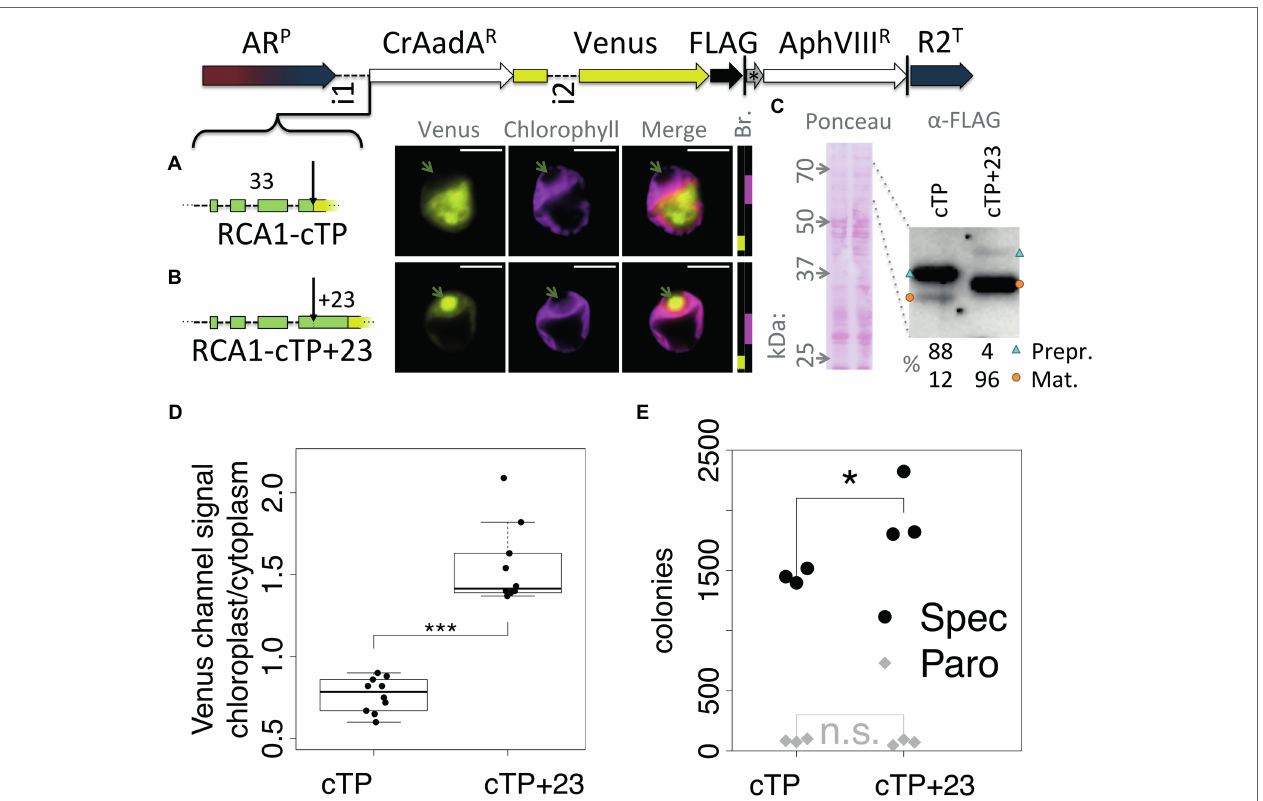
FIGURE 2 | An alternative cargo confirms the requirement for extending RCA1-cTP past the cleavage site. (A–C) The spectinomyin resistance gene AadA, codon optimized for Chlamydomonas (CrAadA R ) and equipped with a short linker sequence at the C-terminus, was inserted between RCA1-cTP ± 23 and Venus, and transformants analyzed using fluorescence microscopy and immunoblotting. Green arrows highlight the pyrenoid in (A,B) ; blue triangles highlight preprotein bands; orange circles highlight mature protein bands in (C) ; and see Figure 1 caption for further details on representation. (D) Epifluorescence images were quantified by measuring mean Venus channel signal inside and outside the chloroplast (***signifies p < 0.001; t -test). (E) Wild-type (T222+) cultures were transformed with either construct in triplicate, and each transformation mix split such that part was plated on 20 μ g ml − 1 Paromomycin plates and part on 1 mg ml − 1 Spectinomycin plates. The plot shows the number of colonies obtained (*signifies p < 0.05; Tukey’s honestly significant difference post-hoc test, after